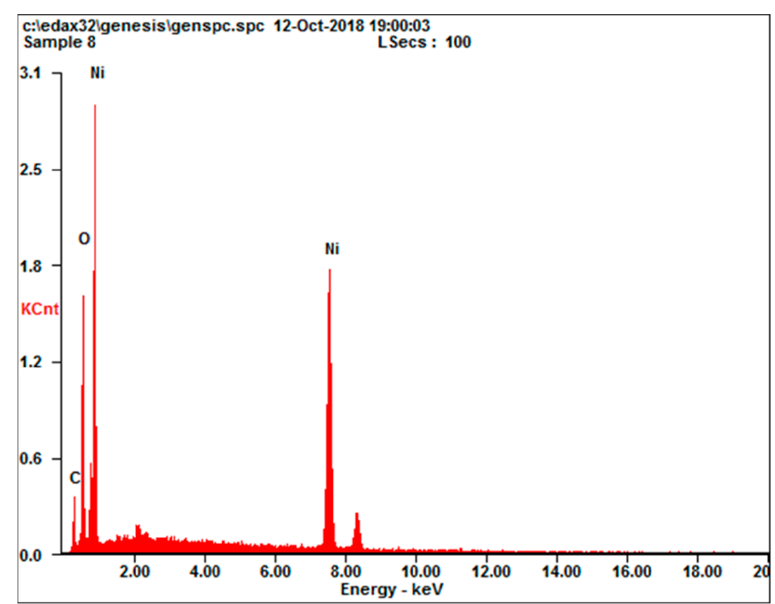
Figure 4. EDX spectra of NiO powder. Powder XRD analysis was used to identify the synthesized NiO powder (Figure 5).